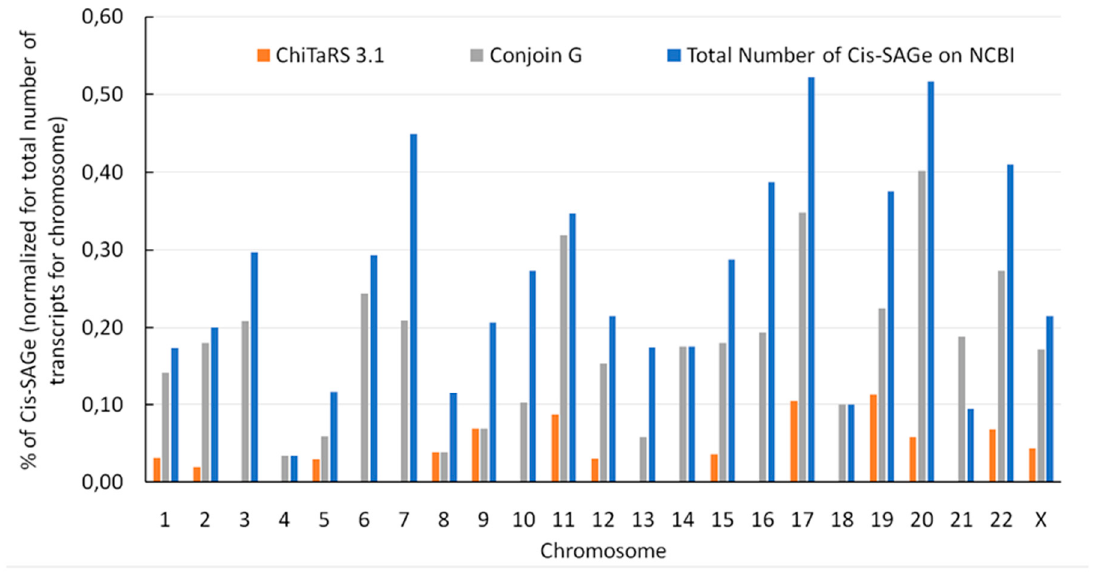
Figure 4. Distribution of FuTAGs in human chromosomes normalized for the total number of transcripts for each chromosome. The results of ChiTaRs v3.1, ConjoinG and NCBI readthroughs are compared.